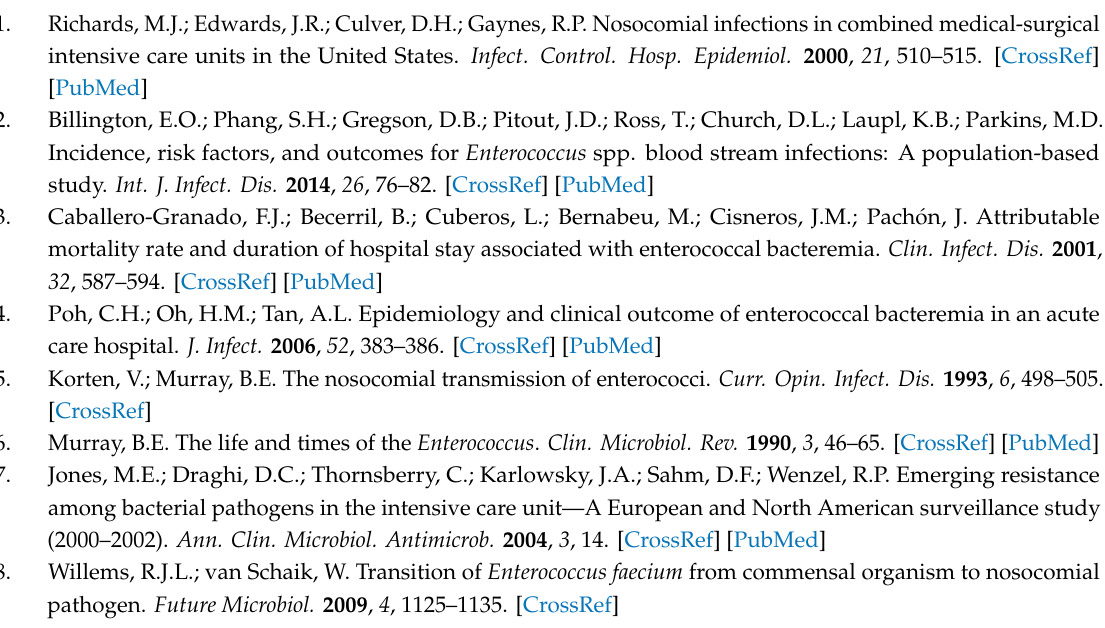
Figure S1: The classification of biofilm formation among E. faecalis and E. faecium isolates; Figure S2: Gel electrophoresis image of esp